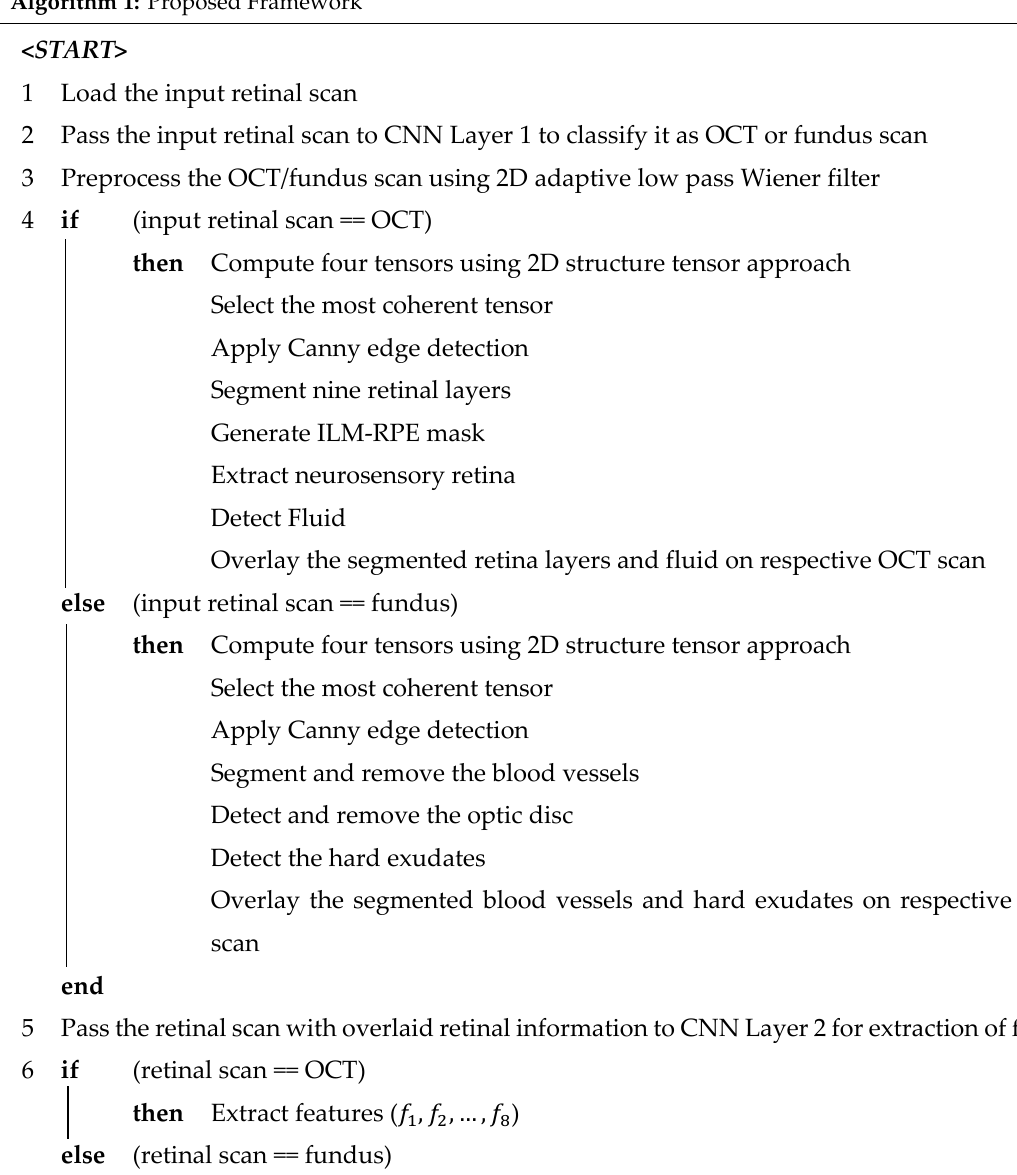
Sensors 2019 , 19 , x FOR PEER REVIEW Algorithm 1: Proposed Framework ALGORITHM I: Proposed